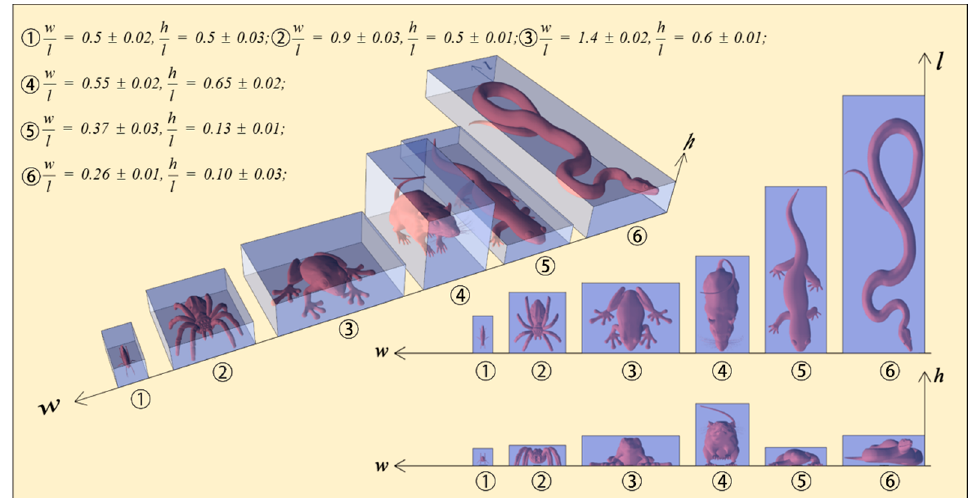
Figure 1. The smallest outer enveloping cuboids (length— l , width— w , height— h ) that completely envelop the animals’ body (the ratio of the width to the length and the ratio of the height to the length of the smallest outer enveloping cuboids of the small animal are in the northwestern corner of the figure).